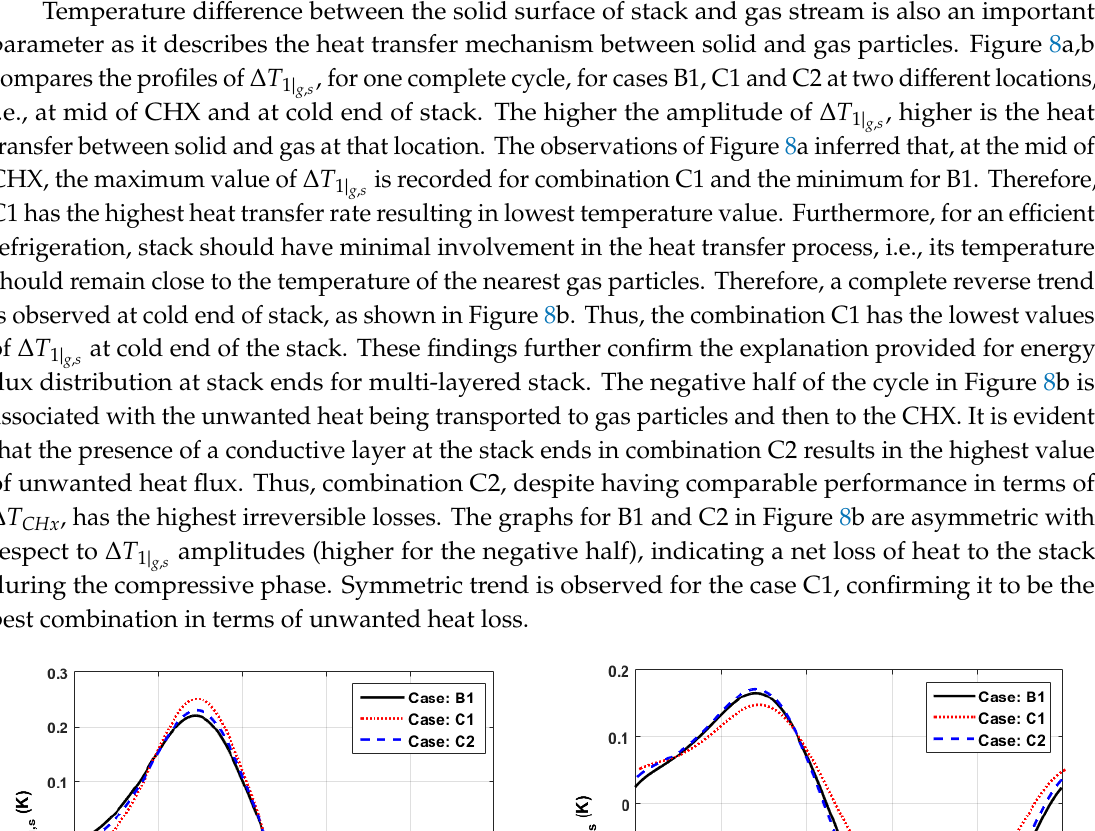
for Celcor based combinations at ( a ) cold heat exchanger (CHX), ( b ) 𝑔,𝑠 g , s